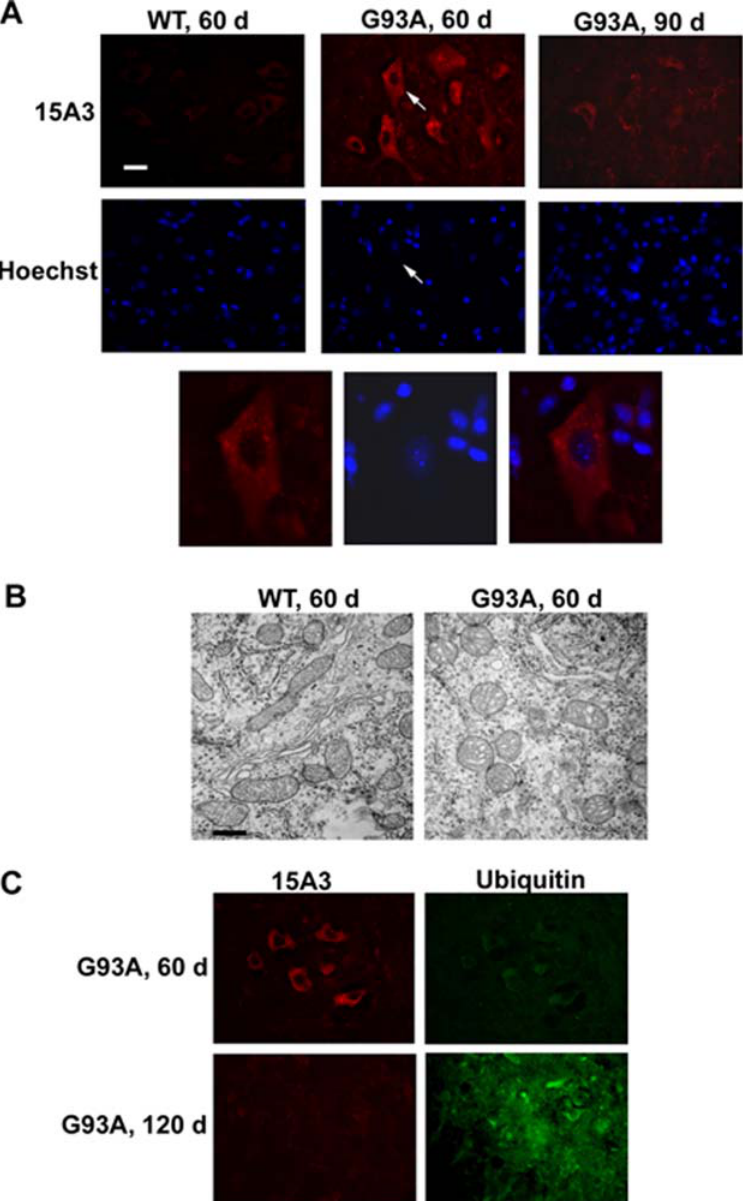
Figure 3. RNA oxidation is an early event preceding motor neuron degeneration. Lumbar spinal cords from indicated age of SOD1 G93A mice ( G93A ) and non-transgenic littermates ( WT ) were examined. ( A ) In the ventral horn, motor neurons with strong 15A3 immunoreactivity had normal nuclear and chromatin morphology by Hoechst 33342 staining; the dying motor neurons showed abnormal nuclear and chromatin morphology but less 15A3 immunoreactivity. Arrows point to the same neuron. Scale bar, 25 m m. ( B ) Motor neurons with strong 15A3 immunoreactivity had only minor mitochondrial vacuolization as examined by electron microscopy. Scale bar, 0.5 m m. ( C ) Motor neurons with strong 15A3 immunoreactivity did not have ubiquitinated protein